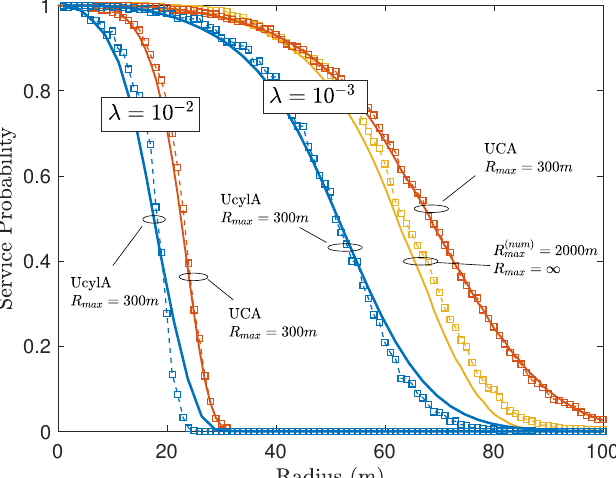
Figure 2. Service probability vs. radius R o for varying λ = { 10 − 3 ,10 − 2 } m − 2 , where the access point (AP) employs a UCA with N c = 128 or a UcylA with N c × N v = 32 × 4. Parameters: R max = ( num ) = 300 m, unless mentioned otherwise; SIR threshold [ T ] R max | β o | = 1, 2 b = 2.6, h = 10